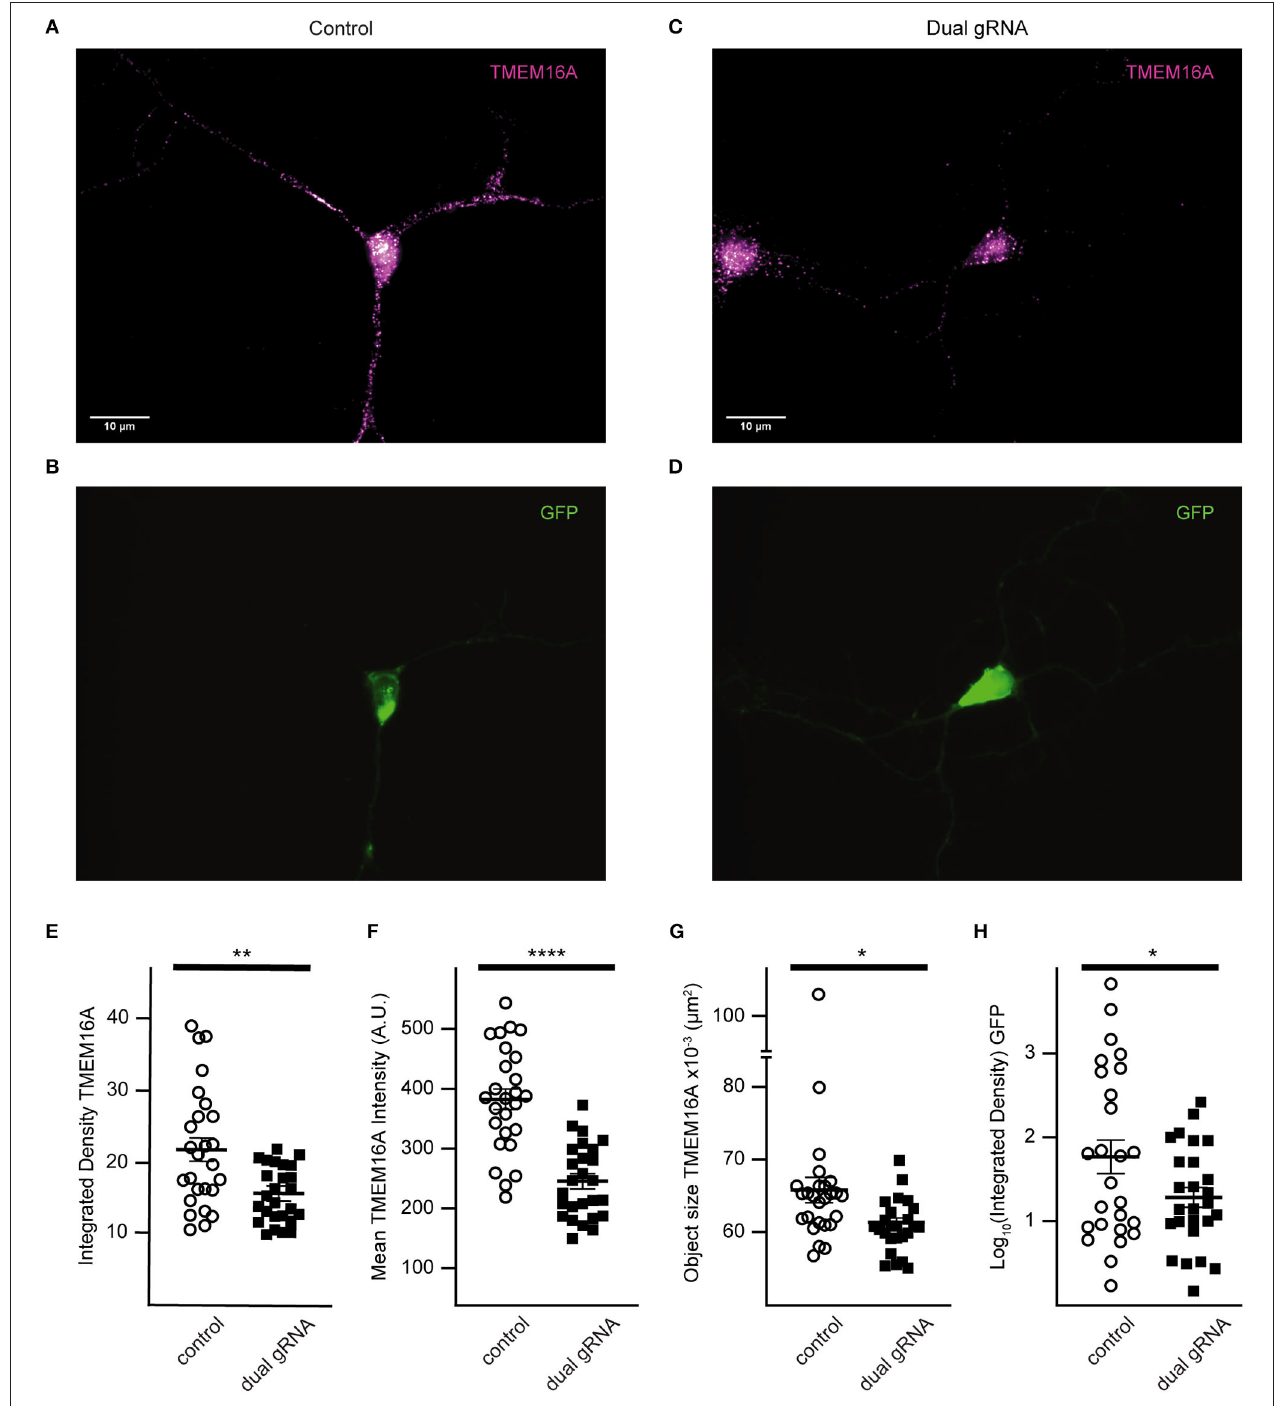
FIGURE 7 | Dual gRNA Cas9 ribonucleoprotein reduces TMEM16A expression (A–D) . Representative immunofluorescence images of GFP expressing amacrine cells labeled with TMEM16A antibodies in control-transfected (A,B) and dual-guide RNA-transfected (C,D) conditions. (E) The mean integrated density for all objects identified within the TMEM16A mask is reduced in the dual-guide condition. (F) The mean fluorescent intensity of TMEM16A objects and the mean TMEM16A object size (G) are significantly reduced in dual-guide RNA-transfected cells. (H) Log-transformed integrated density of the GFP signal is lower in dual gRNA group. * denotes p < 0.05, ** denotes p < 0.005, **** denotes p < 0.00005.